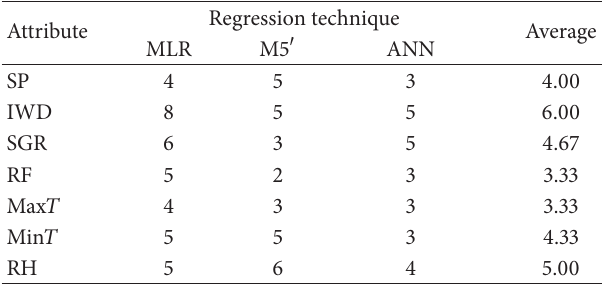
Table 5: Quantity of crop yield models where attributes appear as